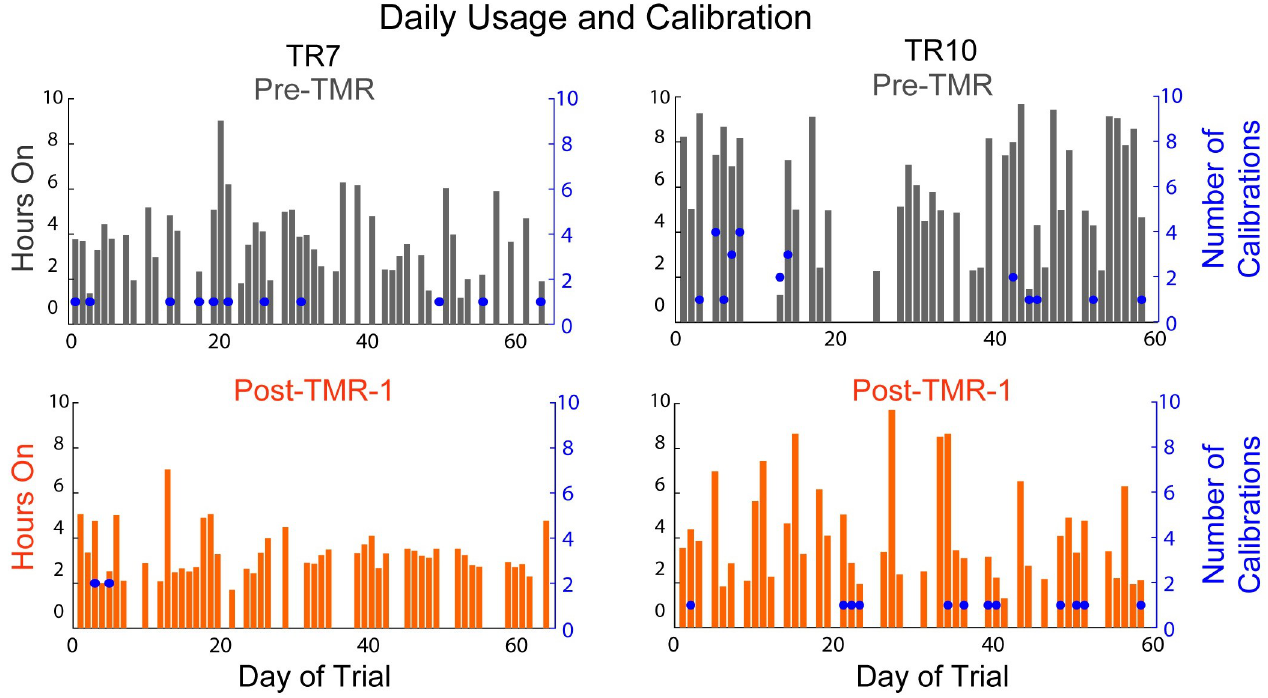
Fig 2. Home usage from two representative participants during the 8-week Pre-TMR ( top ) and 8-week Post-TMR-1 ( bottom ) home trials. Each graph indicates the number of hours the device was turned on (bar, with scale on left-hand axis) and the number of calibrations (dot, with scale on right-hand axis) performed for each day of the home trial. Days of no use were logged as 0 hours on the plots.